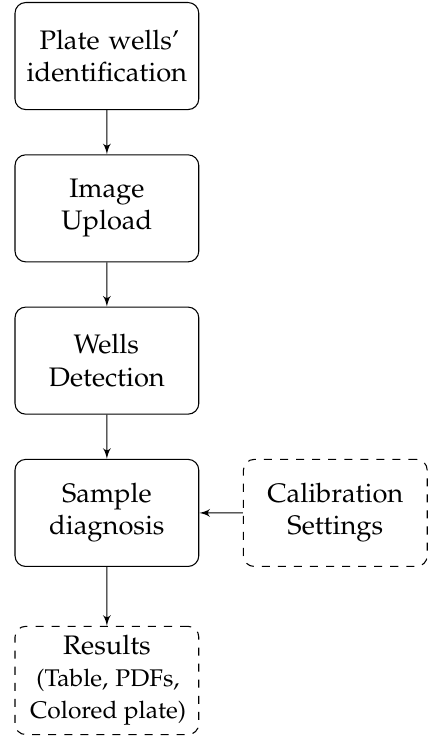
Figure 9. Illustrative scheme for the required steps in an ELISA plate diagnosis.